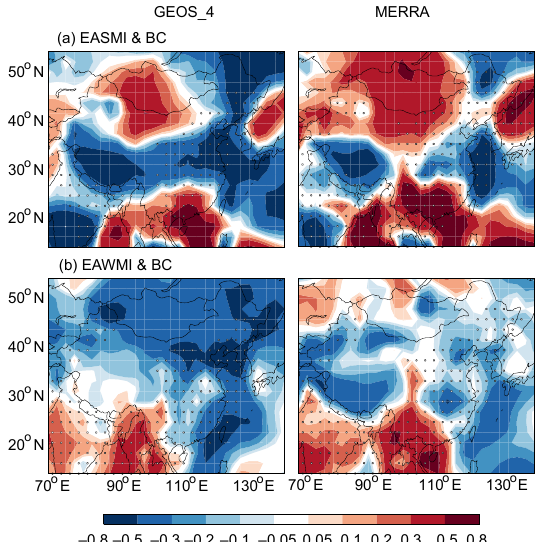
Figure 3. (a) Correlation coefficients between EASMI and JJA mean surface BC concentrations during 1986–2006. (b) Correlation coefficients between EAWMI and DJF mean surface BC concen- trations during 1986–2006. Simulated BC concentrations are from model simulations VMETG4 (left) and VMET (right), and mon- soon indexes are calculated based on GEOS-4 (left) and MERRA (right) assimilated meteorological data. The dotted areas indicate statistical significance with 95% confidence from a two-tailed Stu- dent’s t test. Figure 4. (a1) Absolute (µgm − 3 ) and (a2) percentage (%) differ-